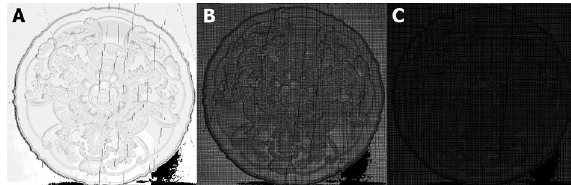
Figure 7. Point clouds of the test object , colour by intensity (greyscale ) acquire from a 5 m distance, with resolution 1/1 (A), 1/2 (B) and 1/4 (C)